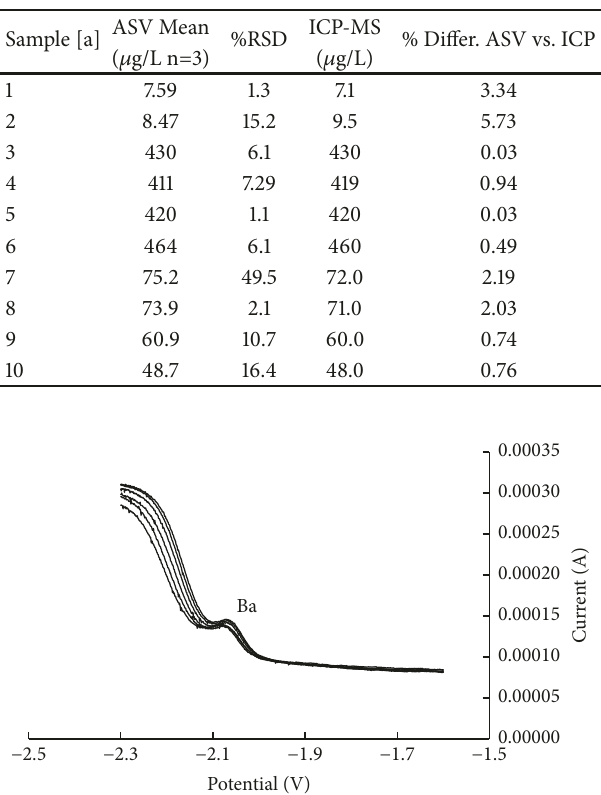
Table 1: Total Ba concentrations determined in 10 drinking water samples, taken from municipal tap water, bores, a rainwater tank, and bottled water in Western Australia. [a] 1. Bottled water (Mt Franklin brand), 2. Rainwater (tank), 3. Drinking fountain water (ECU campus), 4. Tap water (Wanneroo residence), 5. Filtered tap water (Wanneroo residence), 6. Bore (Wangara), 7. Bore (Bulls- brook) 1, 8. Bore (Bullsbrook) 2, 9. Bore (Craigie), and 10. Bore, (Muchea). The F value calculated for these samples is 0.99034.